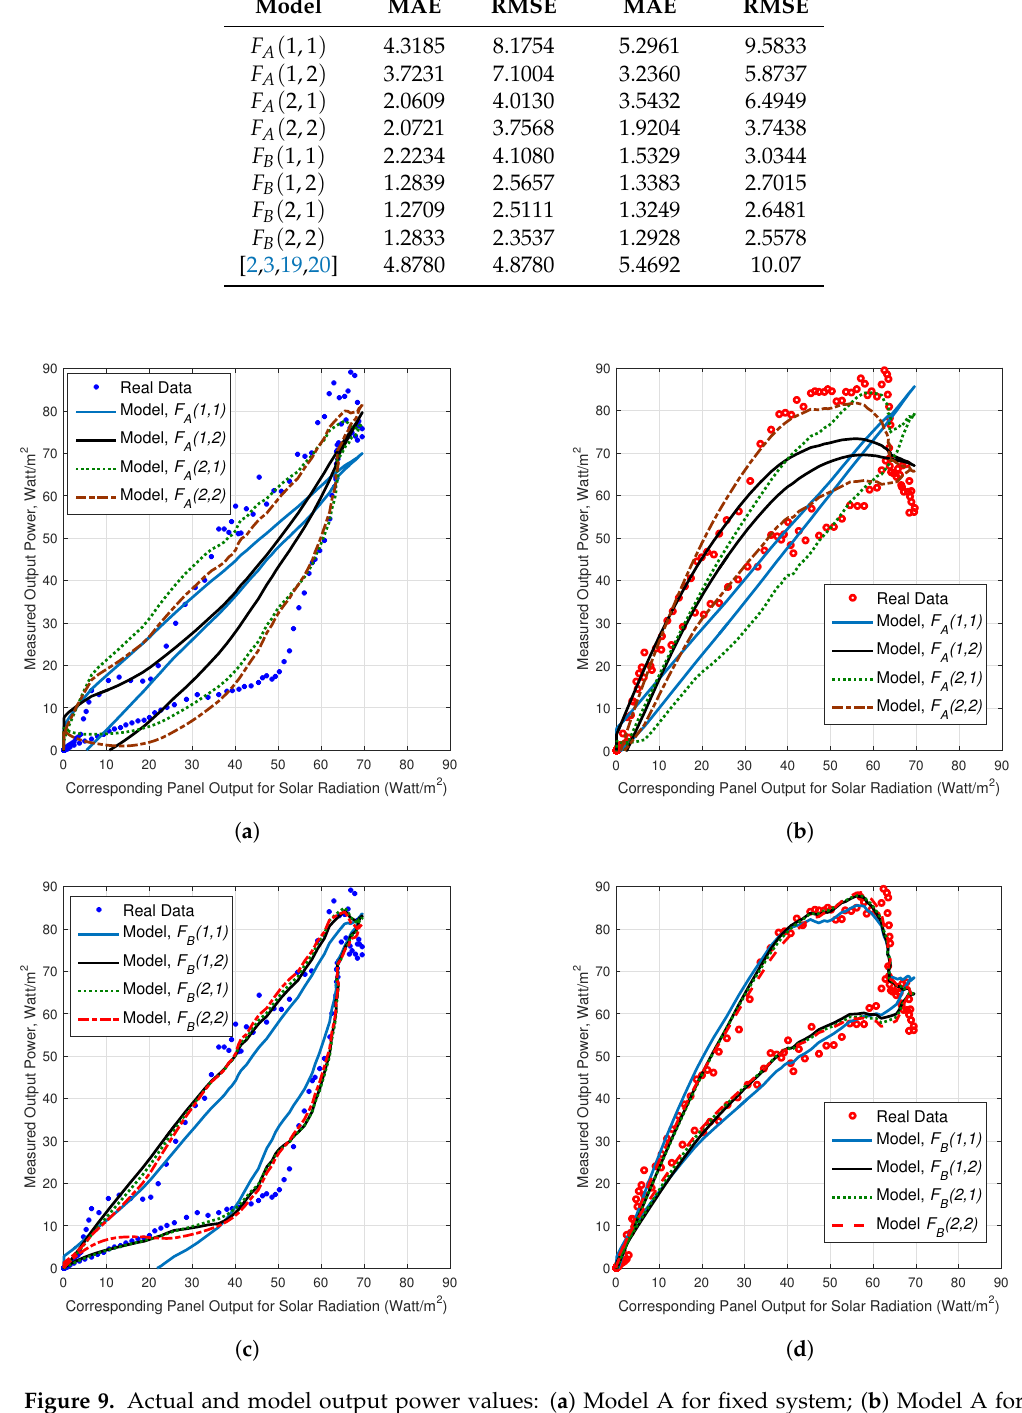
Figure 9. Actual and model output power values: ( a ) Model A for fixed system; ( b ) Model A for tracking system; ( c ) Model B for fixed system; ( d ) Model B for tracking